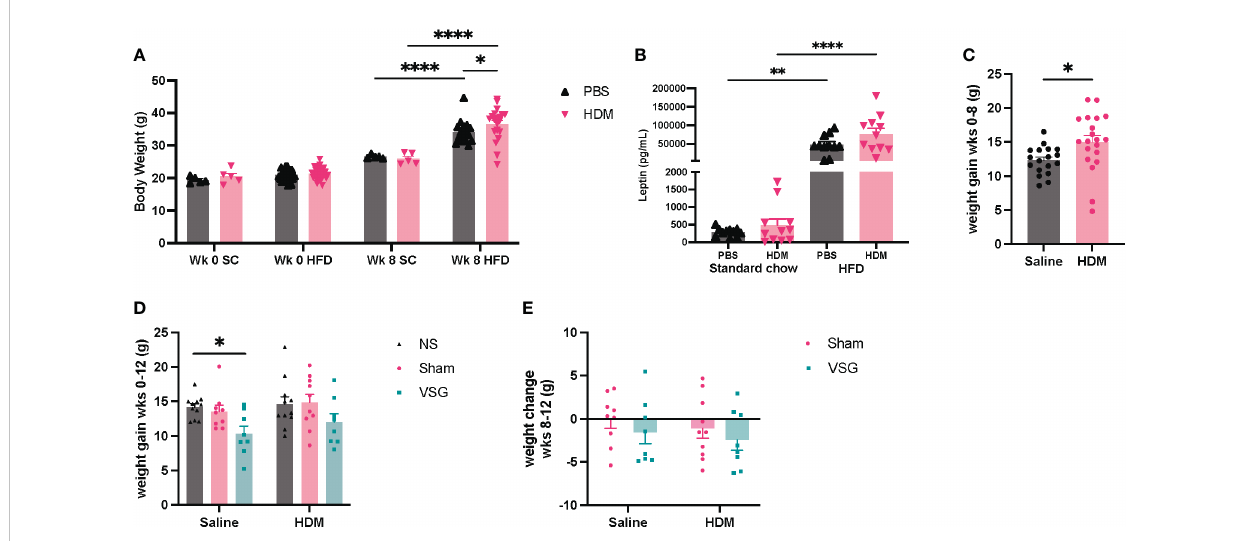
FIGURE 2 Mouse body weight change. (A) Body weight after 8 weeks of HFD or standard chow (SC) diet feeding. (B) Serum leptin levels after 8 weeks of HFD or standard chow diet feeding. (C) Change in mouse body weight from week (wk) 0 to week 8, n=18-20 mice per group. (D) Body weight change in mice from wk 0 to wk 12, n=8-11 mice per group. (E) Body weight change from pre-surgery (wk 10) to post-surgery (wk 12), n=8-10 mice per group. (A, B were analyzed using a Two-way ANOVA with a Tukey and Sidak post-hoc test. (C) was analyzed using a non-parametric t-test. (D, E) were analyzed using a Two-way ANOVA with a Tukey and Sidak post-hoc test. *p<0.05, **p<0.01,